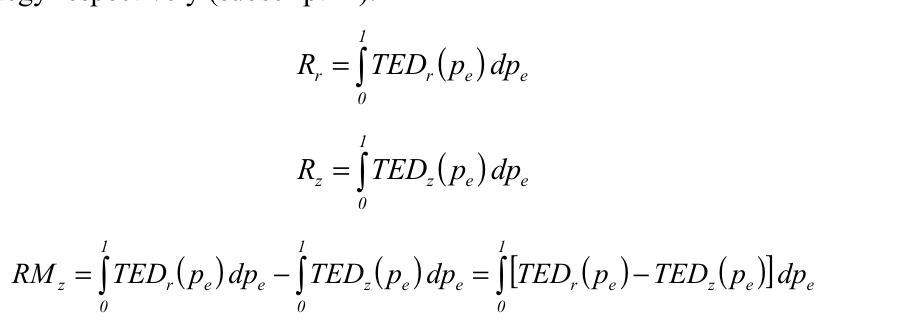
RM of a mitigation z